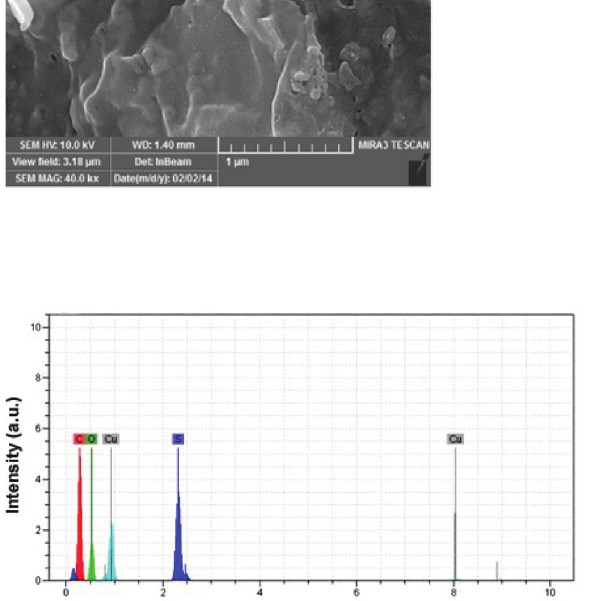
Figure 8: Decolorization of methyl orange dye of posnjakite